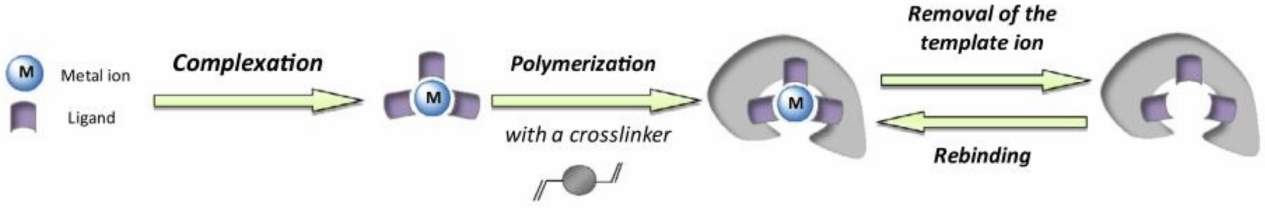
Figure 3. Schematic representation of IIP synthesis. Figure reproduced from [58] with permission from copyright Elsevier 2013.